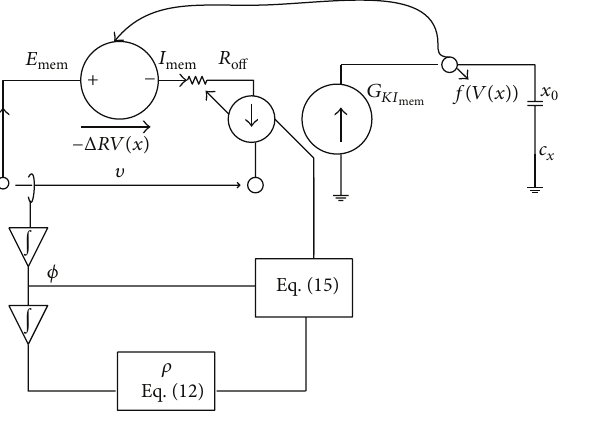
Figure 3: SPICE model of the mutator.